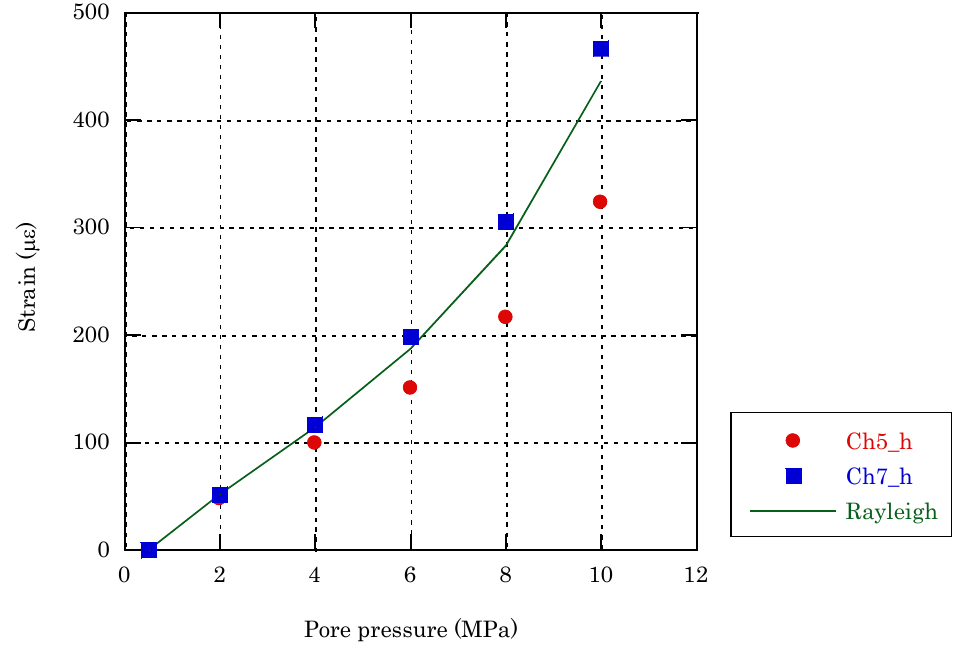
Figure 15. Rayleigh frequency shift-to strain conversions for Berea core vs. strain gauge measurements with increasing pore pressure. The converted strains agree reasonably well with the strain gauge readings from Ch7.